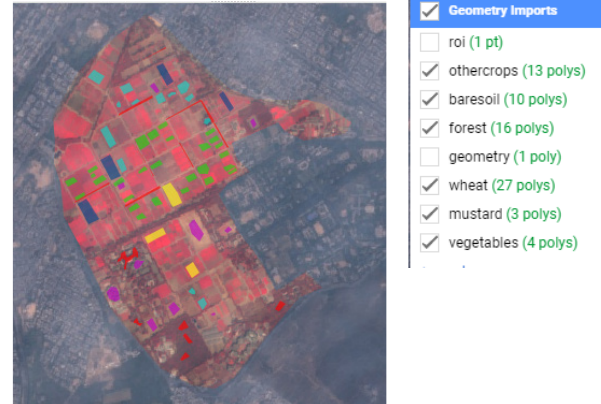
Figure 3. Feature space overlaid on FCC of January, 2016